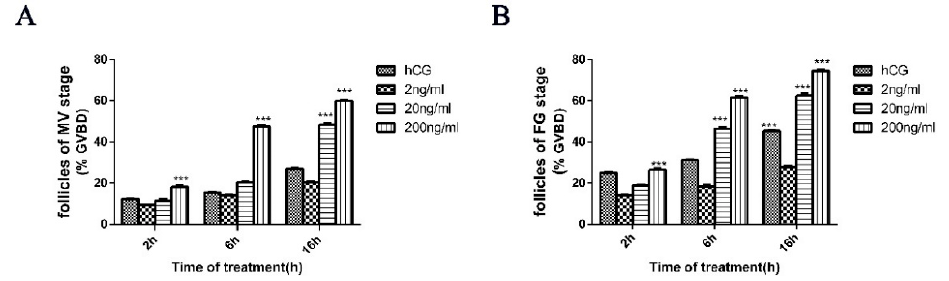
Figure 5. Germinal vesicle breakdown (GVBD) alterations in midvitellogenic (MV) and fully-grown (FG) stages of follicular. Igf3 was added at the ( A ) MV and ( B ) FG stages. ( n = 4). ***, p < 0.001.